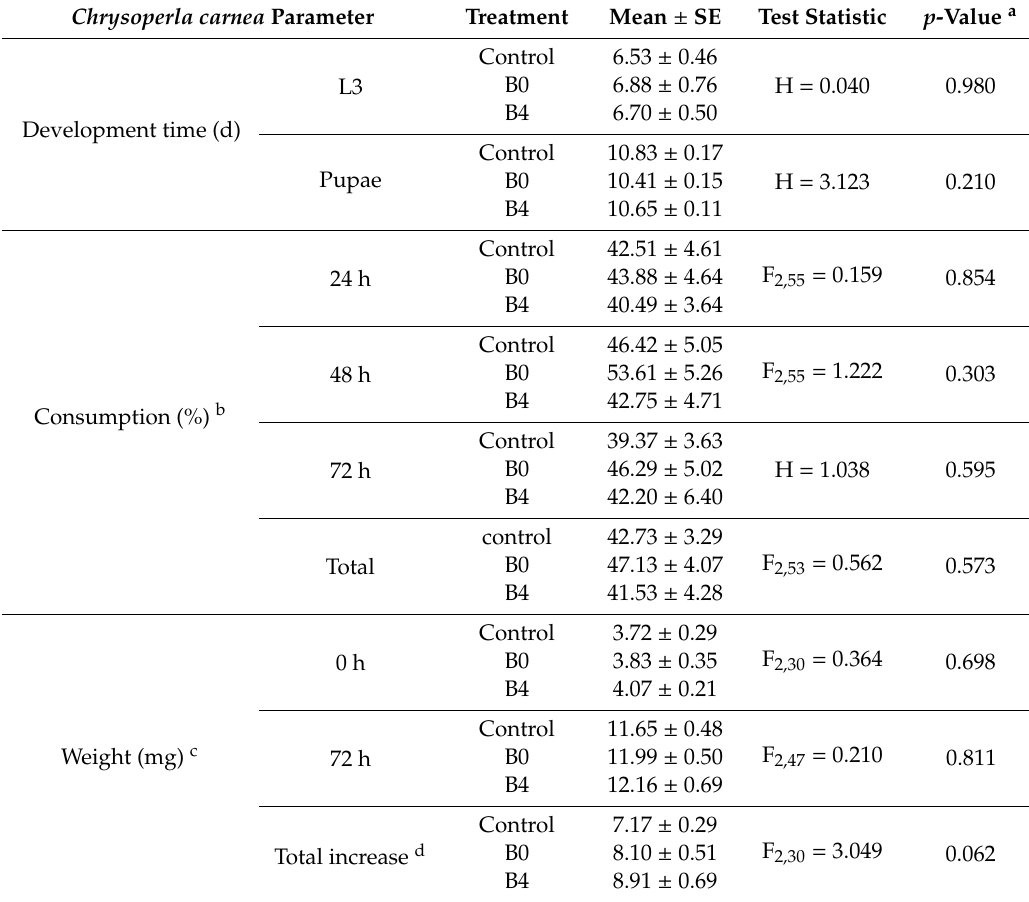
Chrysoperla carnea biology and consumption parameters when third instar larvae (L3) predated forth instar nymphs of Aphis gossypii fed on melon plants treated with BTH (benzo-(1,2,3)-thiadiazole-7-carbothioic-acid S-methyl ester) the day of aphid introduction (B0) or 4 days before (B4), using water-sprayed plants as control.